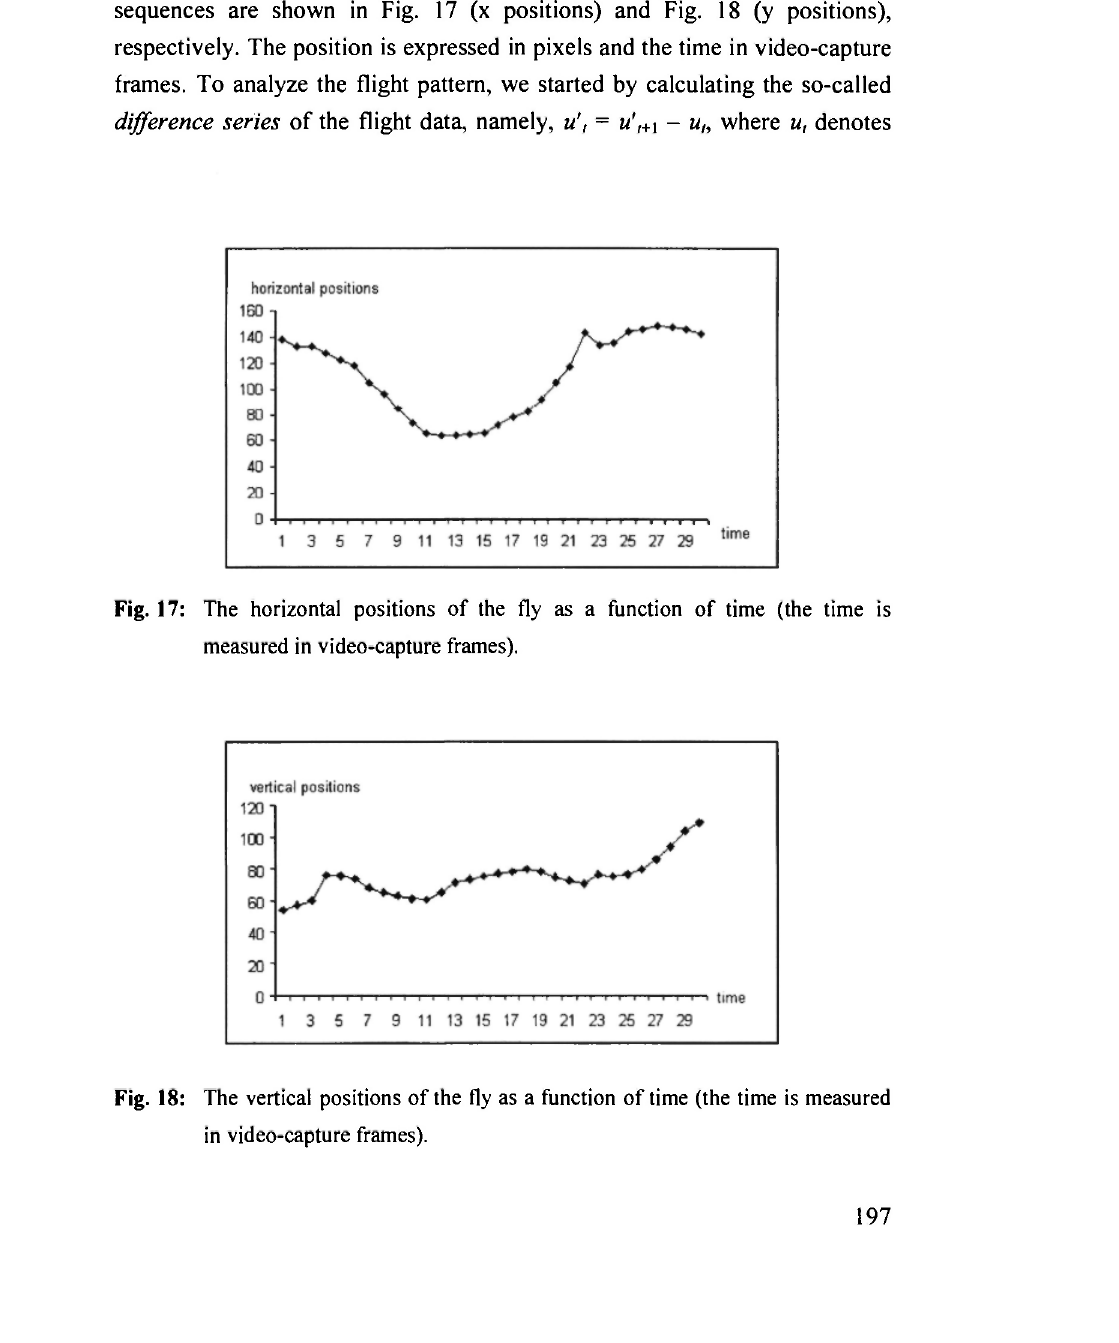
Fig. 18: The vertical positions of the fly as a function of time (the time is measured in video-capture